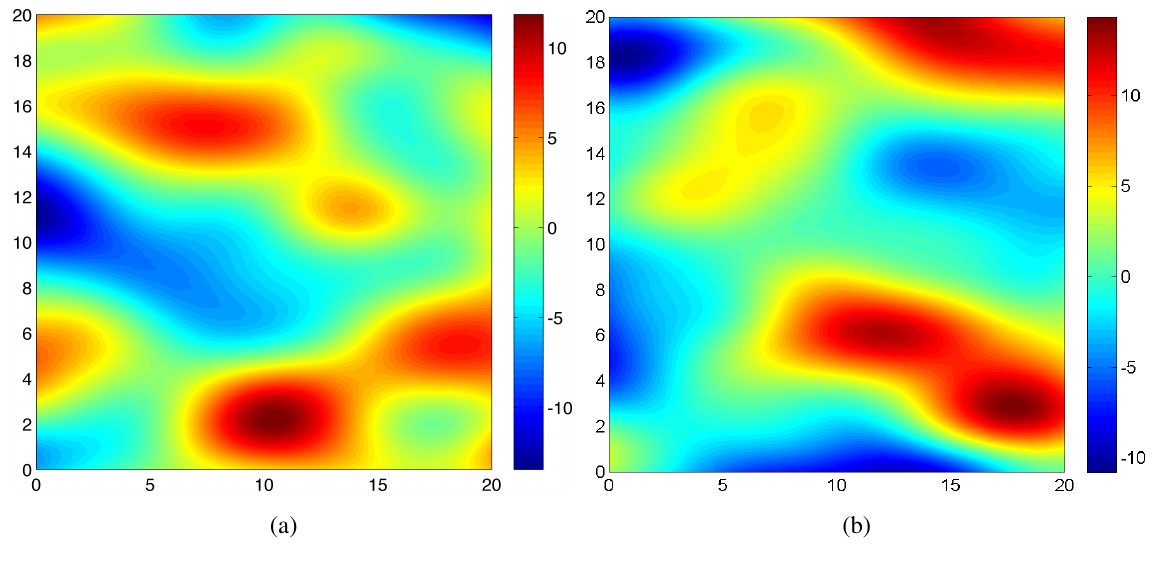
Figure 1. Snap shots of the realized Gaussian process at (a) t = 1 and (b) t = 20